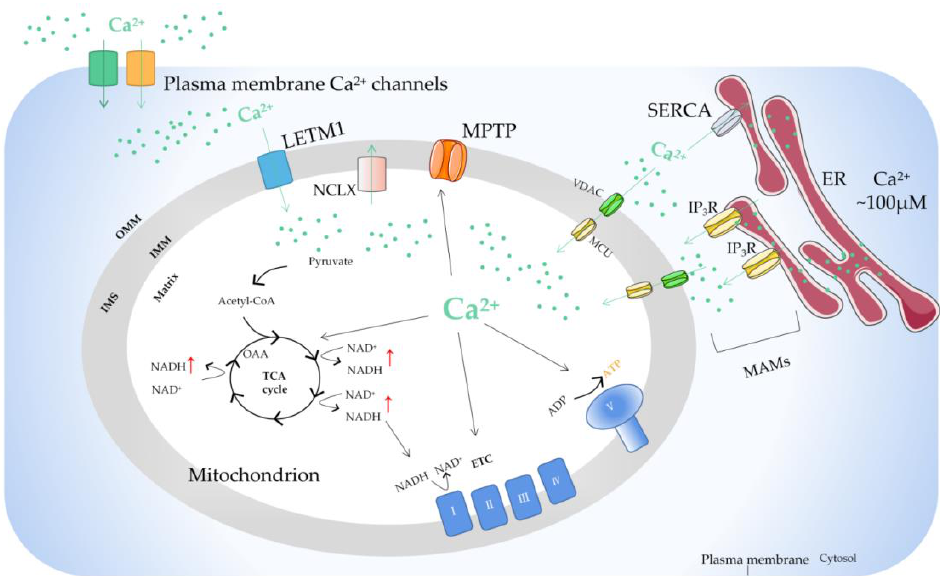
Figure 2. The basic mechanism of mitochondrial Ca 2+ regulation. Ca 2+ transfer from ER to mitochondria occurs on the MAMs, where there are special Ca 2+ channels. The opening of IP3R on the surface of ER results in the release of Ca 2+ from the lumen of ER. Ca 2+ passes through OMM via VDAC and traverses IMM via MCU. Stimulus acts by producing Ca 2+ mobilization signals, triggering the increase of intracellular Ca 2+ concentration. The function of mitochondrial Ca 2+ uptake and release are mainly to regulate the matrix Ca 2+ level, thus regulating the activity of mitochondrial dehydrogenase, resulting in increased NADH and ATP production. Ca 2+ can also activate mitochondrial ETC complexes. In the steady state, Ca 2+ entering mitochondria through MCU must exit through one of the mitochondrial Ca 2+ efflux mechanisms. ER, endoplasmic reticulum; MAM, mitochondrial-associated ER membrane; IP3R, inositol triphosphate receptor; MCU, mitochondrial calcium uniporter; VDAC, voltage-dependent anion-selective channel; ETC, electron transport chain; OMM, outer mitochondrial membrane; IMS, intermembrane space; IMM, inner mitochondrial membrane; LETM1, leucine zipper/EF hand-containing transmembrane-1; MPTP, mitochondrial permeability transition pore; NCLX, mitochondrial Na + /Ca 2+ exchanger; SERCA, sarco-endoplasmic reticulum Ca 2+ -ATPase; OAA, oxaloacetic acid; TCA cycle, tricarboxylic acid cycle.